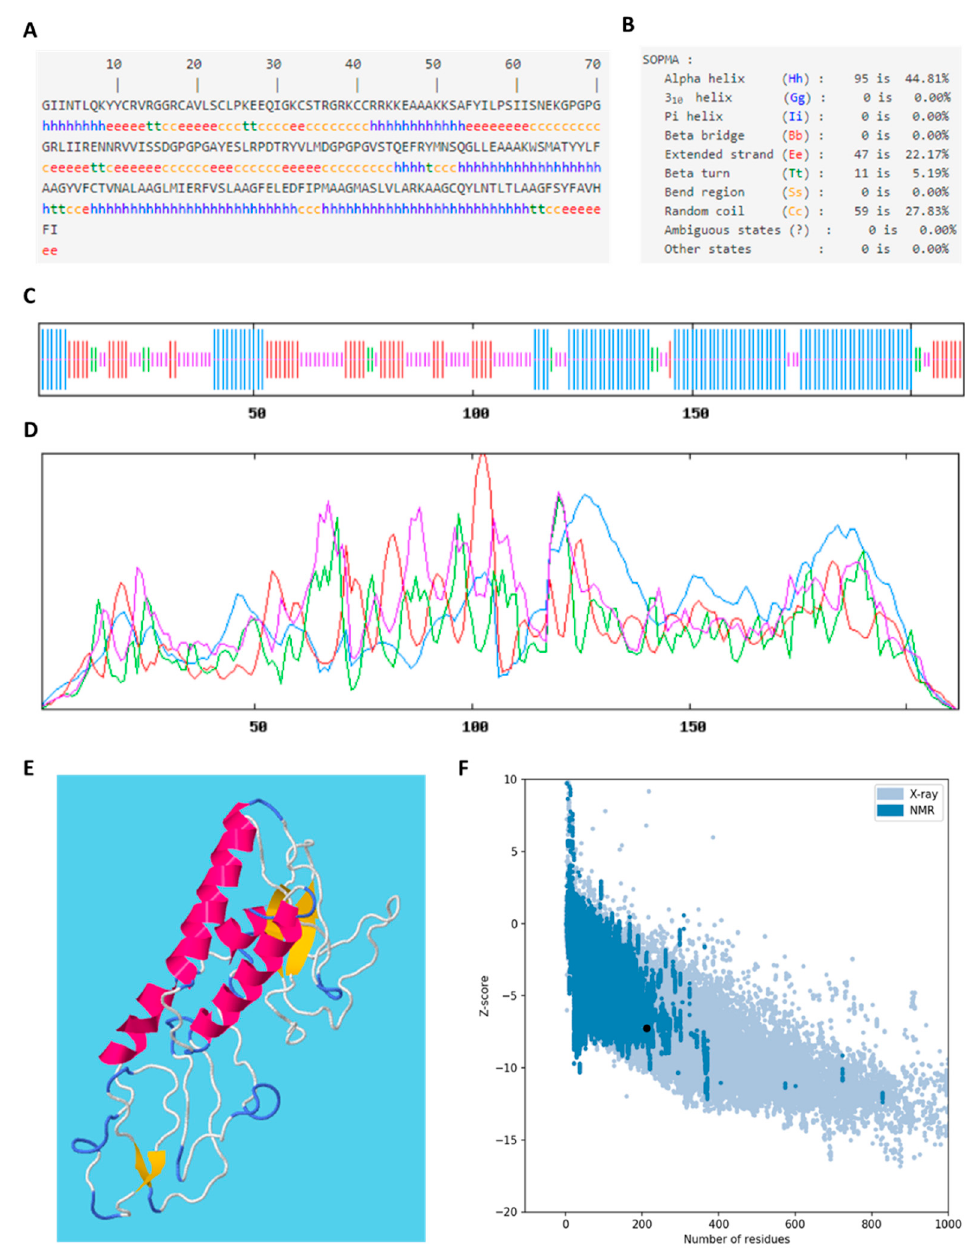
Figure 8. The secondary and tertiary structure of the VC: ( A ) Amino acid sequence and position of the secondary structure. ( B ) The global composition of the secondary structure of the VC. ( C ) Position of secondary structure within the protein sequence. The secondary structure is color-coded with blue— α -helix, red—extended strand, green— β -turn, and purple—random coil. ( D ) The propensity of each residue in adopting the secondary structure. ( E ) Tertiary structure as predicted by RAPTOR X (3D model) of the VC. ( F ) z-score value of the 3D model of the VC as calculated by ProSAweb is − 7.25 (indicated by a black dot), which falls within the range of the z-score for the native proteins of similar size (212 aa).